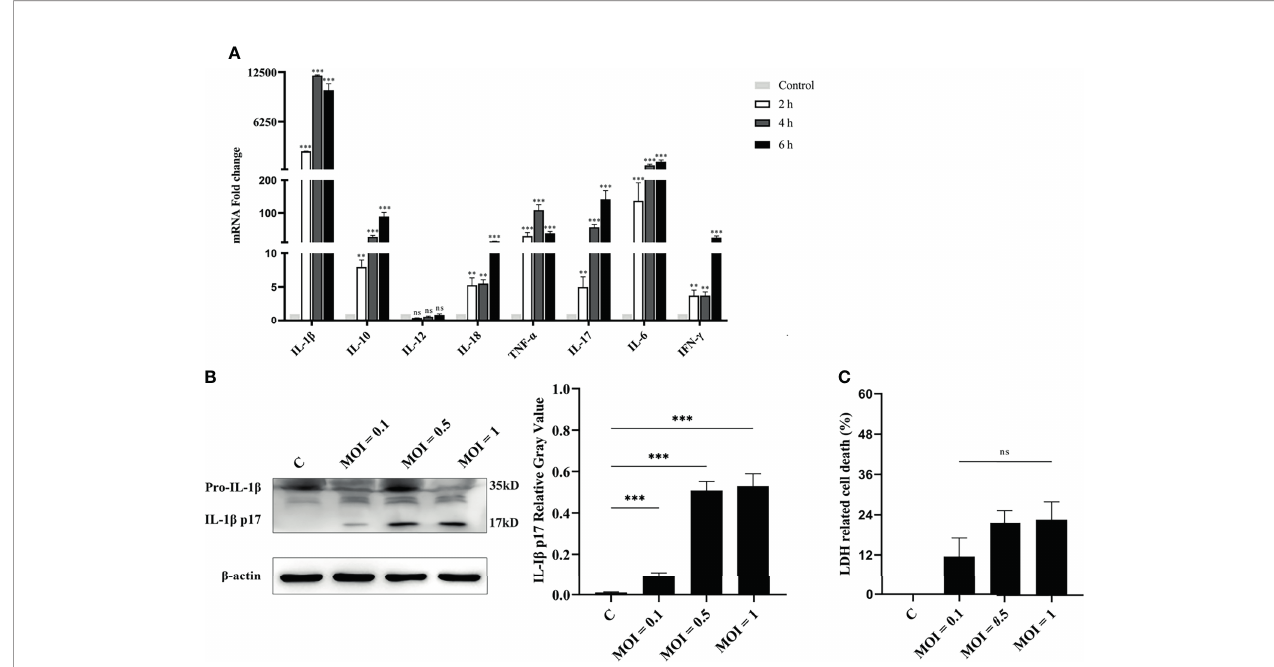
FIGURE 1 | V. alginolyticus induced pro-in fl ammatory cytokine secretion in mouse peritoneal macrophages. (A) Macrophages were infected with V. alginolyticus at an MOI of 1 for 2, 4, and 6 h Then, the mRNA levels of various in fl ammatory cytokines such as IL-1 b , IL-6, IL-12, TNF- a , IL-17, IL-18, and IFN- g and anti-in fl ammatory cytokine IL-10 were tested using qPCR. (B) Macrophages were infected with V. alginolyticus at MOIs of 0.1, 0.5, and 1 for 12 h, and the protein expression levels of IL-1 b p17 in the cell supernatants were examined by Western blotting. The relative gray value of IL-1 b p17 was normalized to b -actin in the cell lysates. (C) Cell death was monitored by measuring LDH release in supernatants after infection with V. alginolyticus for 12 h. Data were representative of at least three independent experiments. ns, not signi fi cance, ** p < 0.01, and *** p <